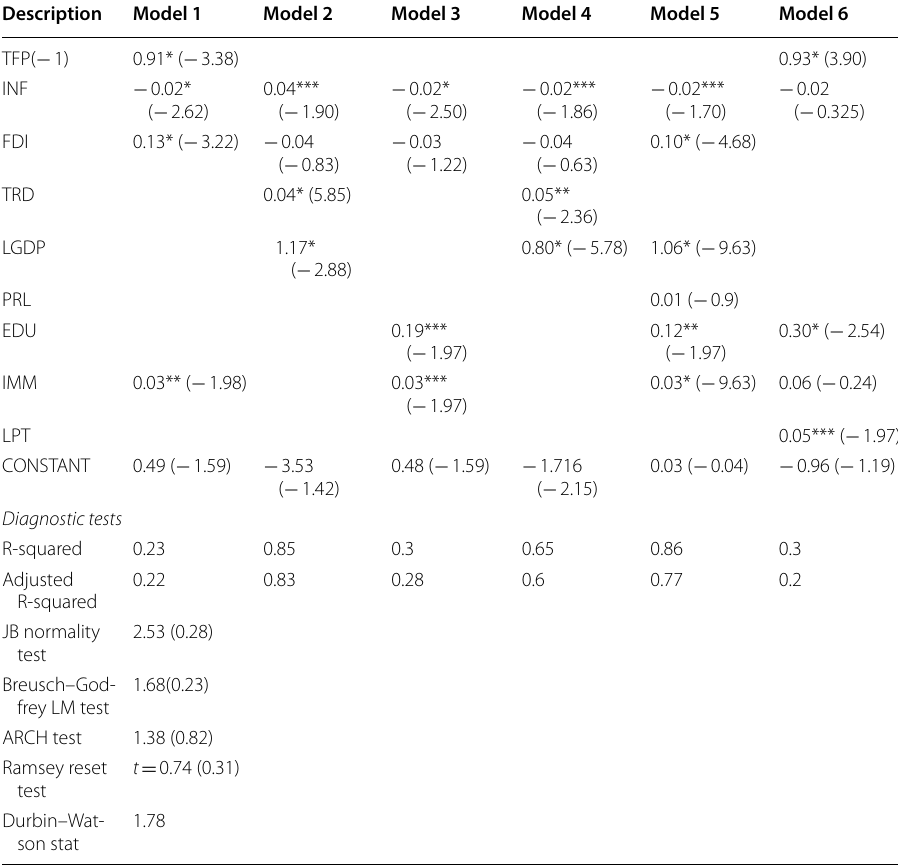
Table 3 The determinants of TFP (2SLS